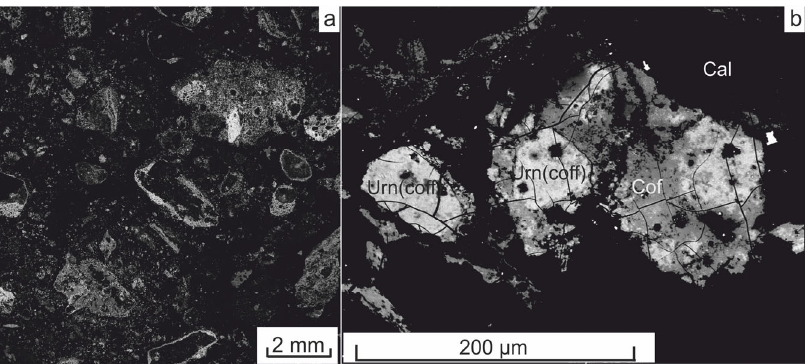
Figure 4. ( a ): The BSE image of breccia with uranium mineralization (white spots) embedded in the carbonate filling of the synchysite-bearing vein. ( b ): Close-up of the coffinitized uraninite and coffinite in the breccia fragment. An irregular shape of the coffinite accumulations indicate its corrosion and dissolution. Explanation: Urn(cof): coffinitized uraninite; Cof: coffinite; Cal: